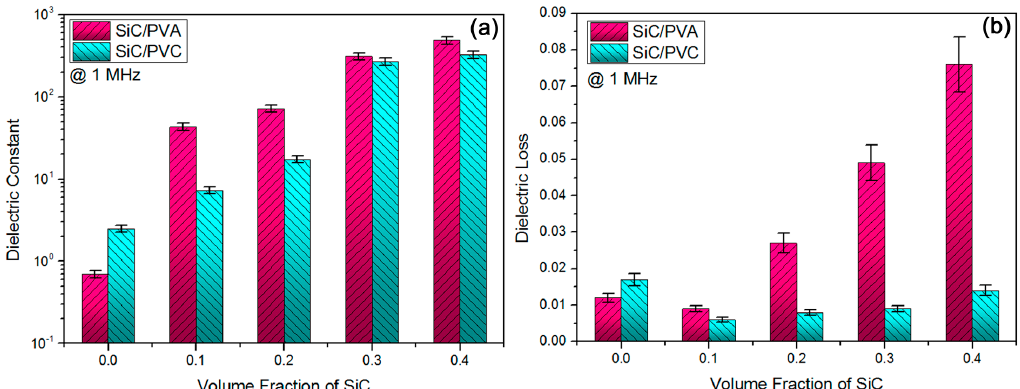
Figure 2. ( a ) Dielectric constant data showed both induced polarization and electric percolation in two composite systems, and ( b ) loss results suggested superiority of polyvinyl chloride (PVC)-based system to polyvinyl alcohol (PVA)-based system.